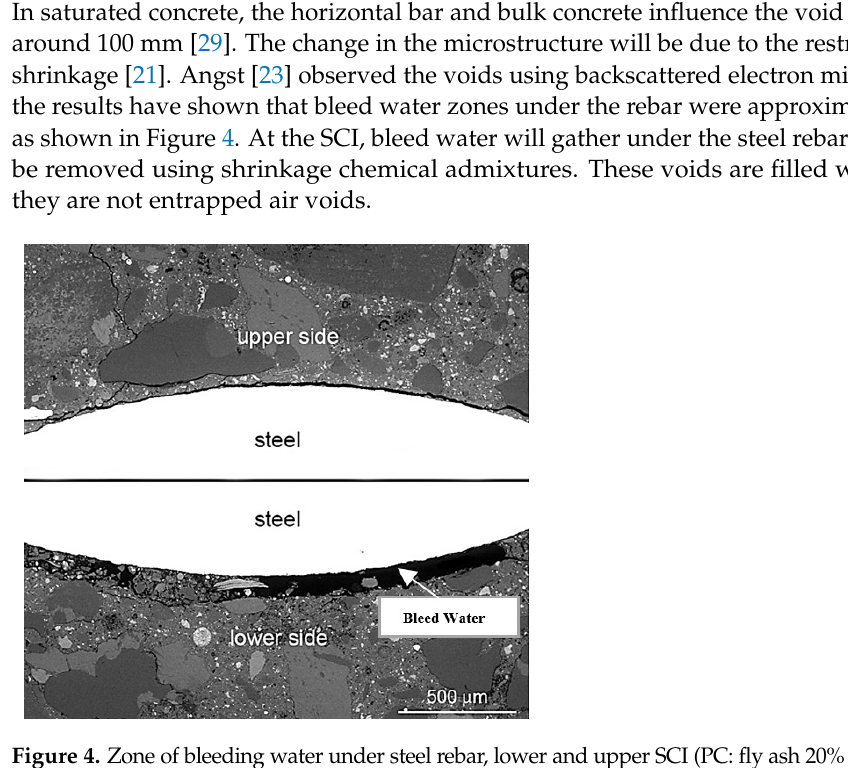
Figure 3. E ff ect of steel-concrete distance on the porosity and thickness of SCI (Reproduced with permission from reference [29]).